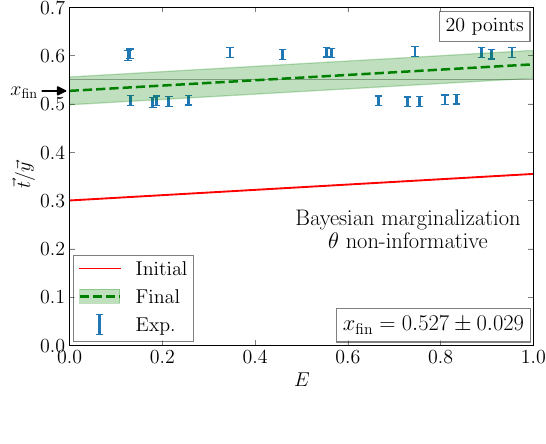
Figure 5. Uncertainty propagation in the Bayesian marginaliza- tion